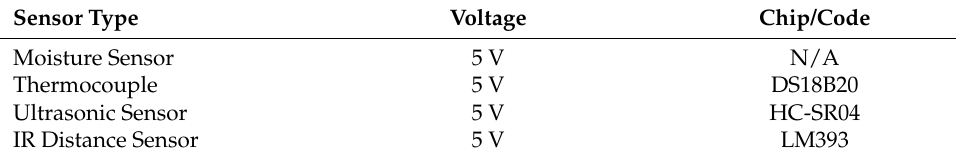
Table 7. Sensors tested for power consumption.